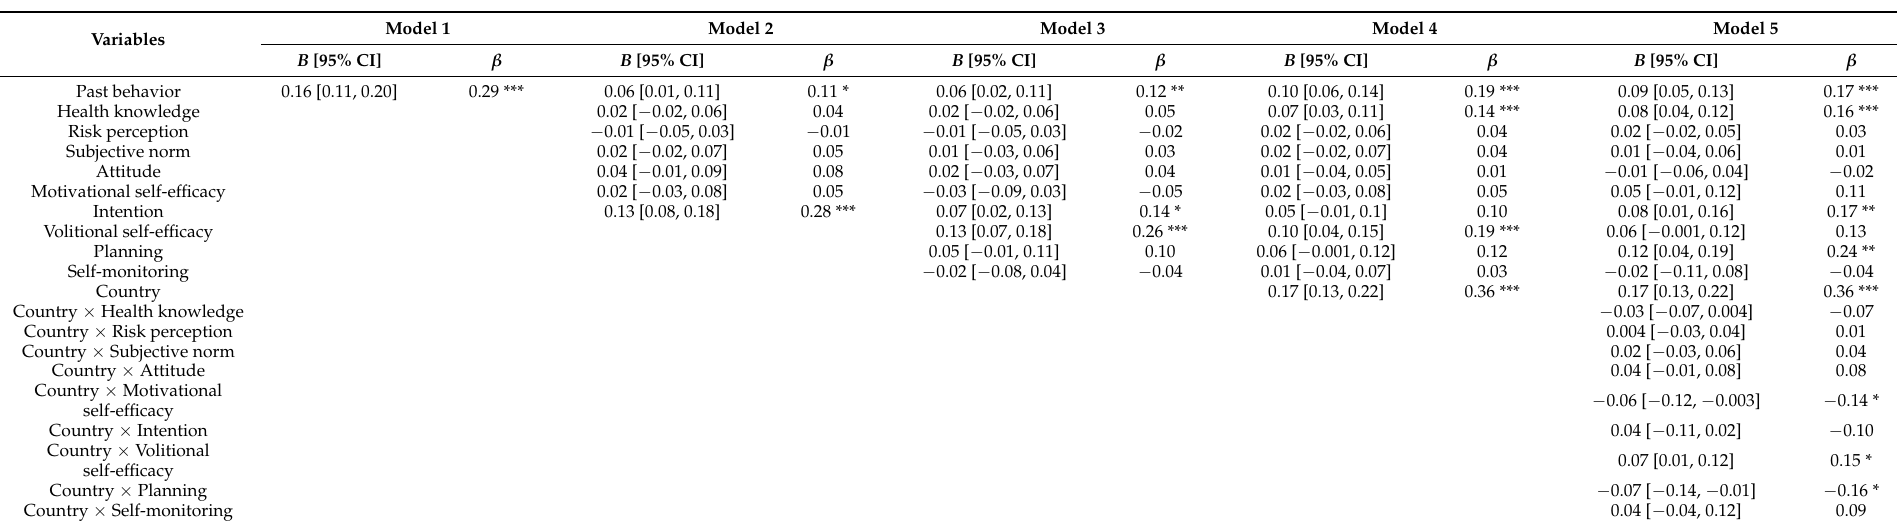
Table 5. Multiple hierarchical regression results for prediction of physical distancing behavior ( n =